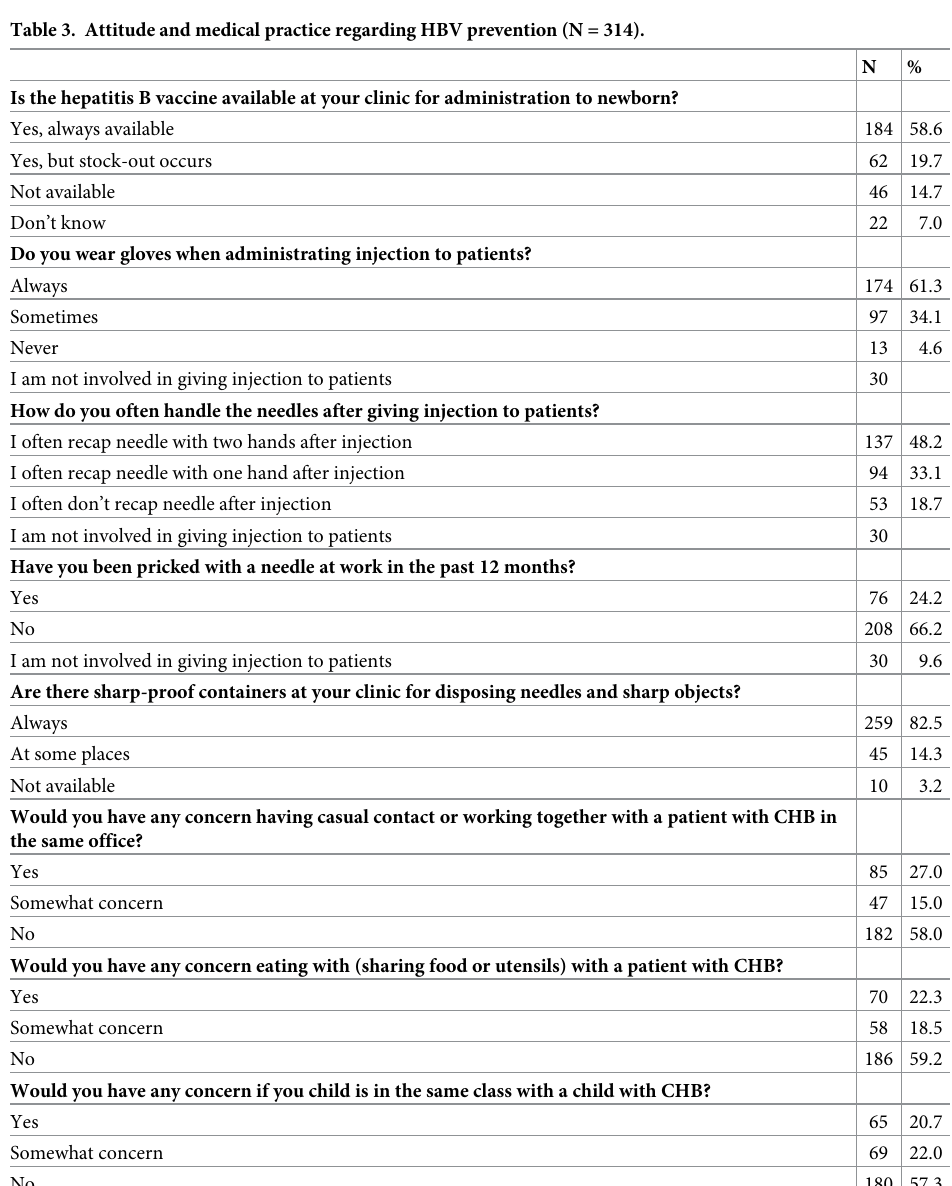
Table 3. Attitude and medical practice regarding HBV prevention (N = 314).